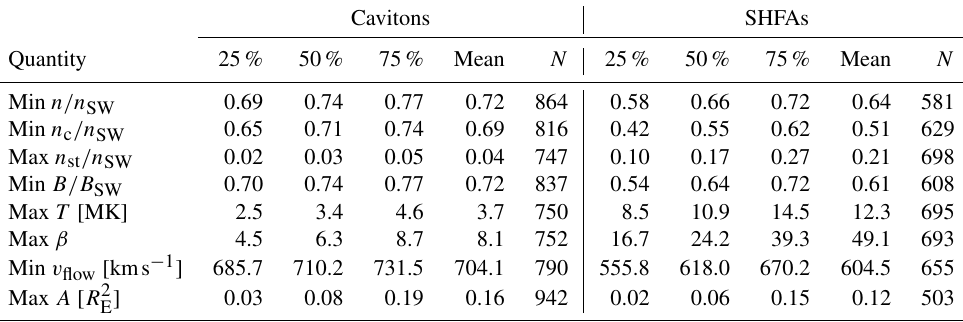
Table 1. Statistics of the physical properties of the tracked transients. The columns show the 25th/50th/75th percentile values, the mean value and the sample size ( N ) for each property listed in the left column. The presented properties are extrema over transient lifetime. The transients are classified into cavitons and SHFAs according to their type at each property extremum. From top to bottom: Total proton number density plasma β , bulk flow speed v flow and transient area A . The densities and the magnetic field magnitude are normalised to the input solar wind values. Cavitons